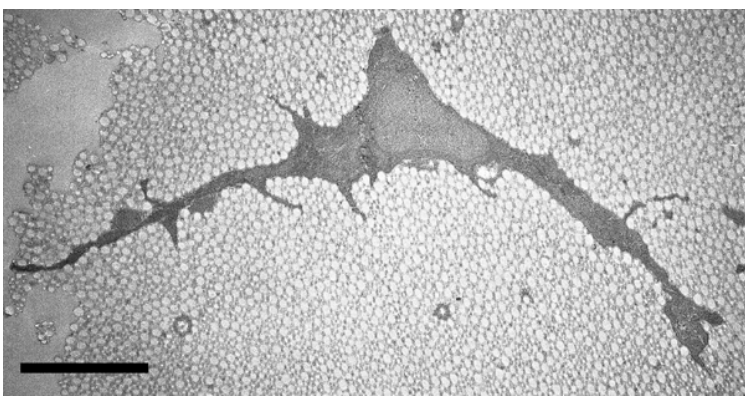
FIGURE 5. TEM image of cross-sectioned collagen fibrils and a tenocyte showing long and thin cytoplasmatic processes. Bar = 2.5 μ